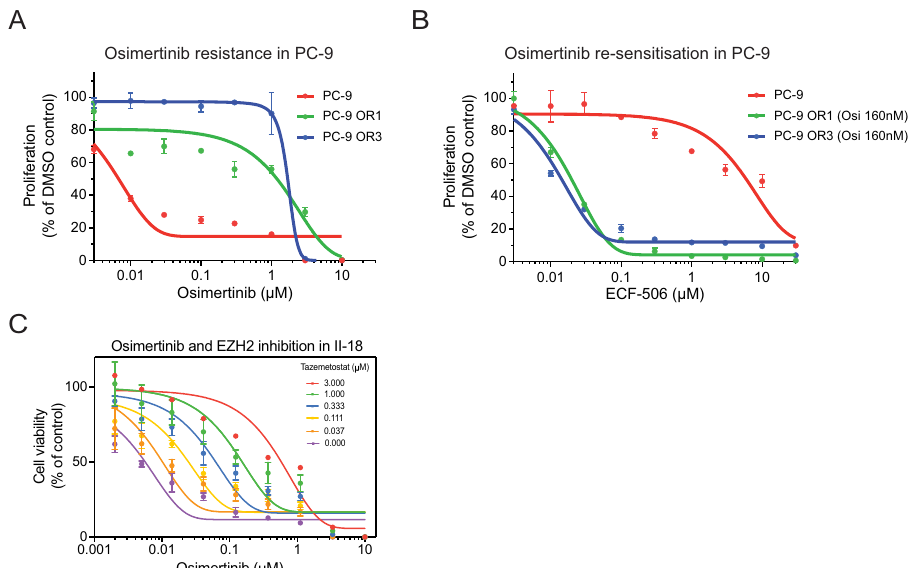
Fig. 6 Validation of SRC and EZH2 as resistance drivers proposed by recommendation system. A Osimertinib dose – response curve in PC9 parental cells compared to two lines derived to have acquired osimertinib resistance, as measured by Cell Titer Glo (96h treatment). B ECF-506 (SRCi) dose – response curve in PC9 parental vs. resistant lines, as measured by Cell Titer Glo (96 h treatment). Resistant cells were co-treated with 160 nM osimertinib. C Viability assay demonstrating dose-dependent effect of EZH2 inhibition on osimertinib resistance in II-18. OR = osimertinib (Osi) resistant. Data are presented as mean values + / – SD ( n = 3) of a typical plot, where the experiment was repeated at least three